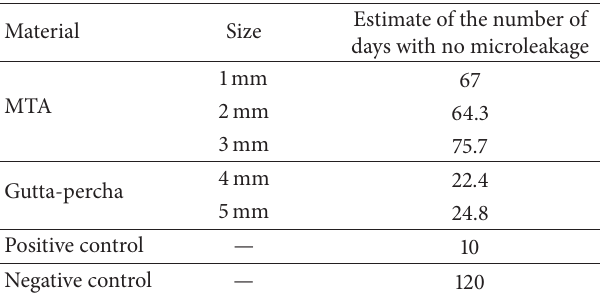
Table 2: Estimation of means intervals of no microleakage in each group.